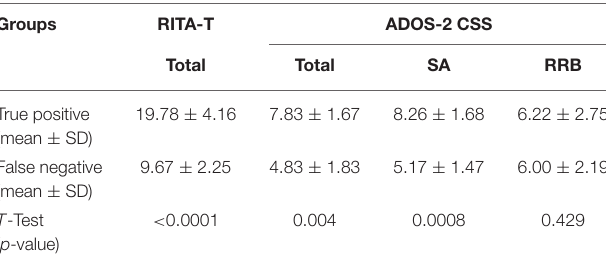
TABLE 2 | Comparison of ADOS-2 CSS and RITA-T scores between true positive subjects and false negative subjects. Groups RITA-T ADOS-2